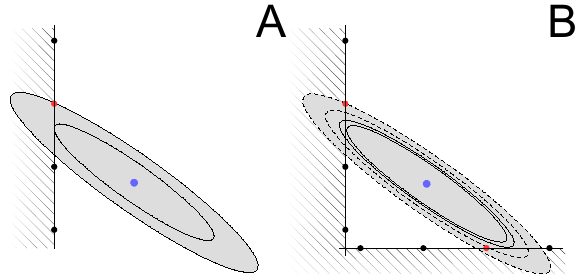
Figure 4. Sketch of the effect of surface reconstruction on matching between a LiDAR point cloud (black/red dots) and a PS-InSAR geolocation estimation (blue dot, including error ellipsoids). The match with Nearest Neighbour in the point cloud, shown in red, is much further away than the actual surface (thin black line). Shown in a simple situation A; and a complex situation B. Although the horizontal surface is further away, it could be considered a candidate